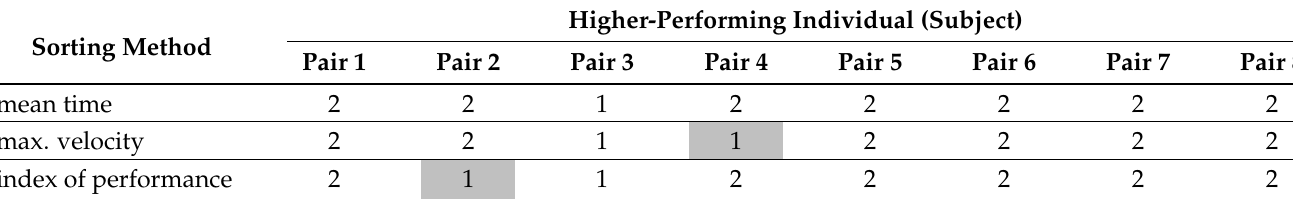
Figure 2. Fitts’ law models of individual and collaborative tasks for each pair, independent of the sorting method used. Here, subjects are defined as subject 1 and subject 2 as they are not yet determined to be either higher-performing or the lower-performing subjects. Whether subject 1 or 2 is determined to be the higher-performing individual and the other as the lower-performing one can be found in Table 1 for different sorting methods. Table 1. Table showing which subject was defined as the higher-performing individual based on all sorting methods. The cells marked in gray show which sorting method produced a different higher-performing individual than the